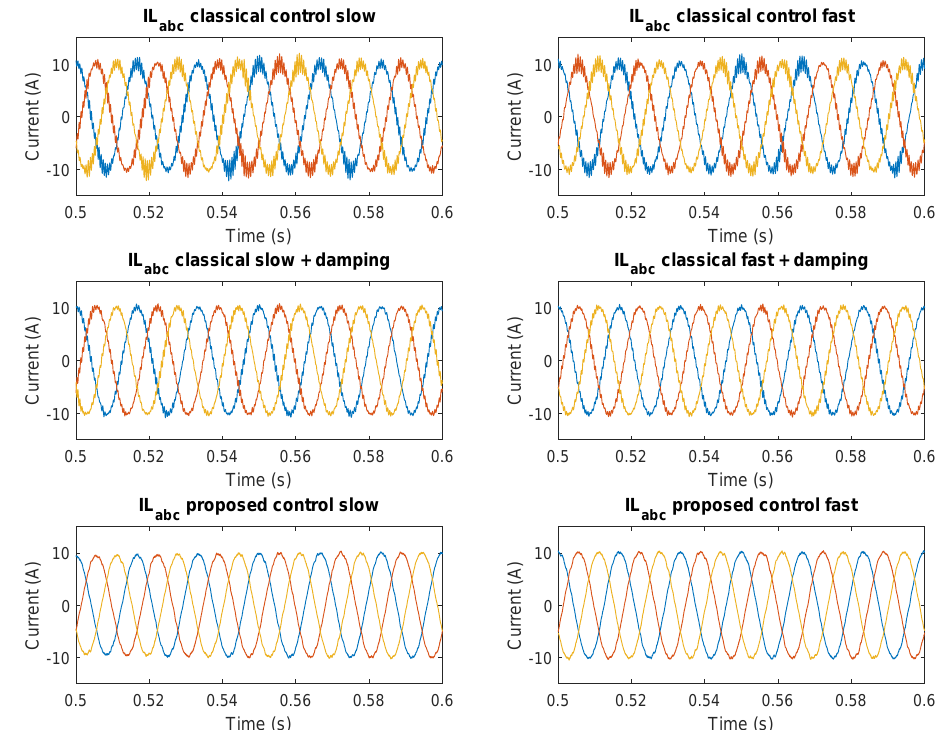
Figure 12. Simulation results: grid current in a steady state with the classical control without a damping method ( top ), with a damping method ( middle ), and with the proposed control ( bottom ) regarding the magnitude of the oscillations. Grid voltage is at 110 V with a 10 Ω resistive load. Other parameters are listed in Tables 3 and 4.